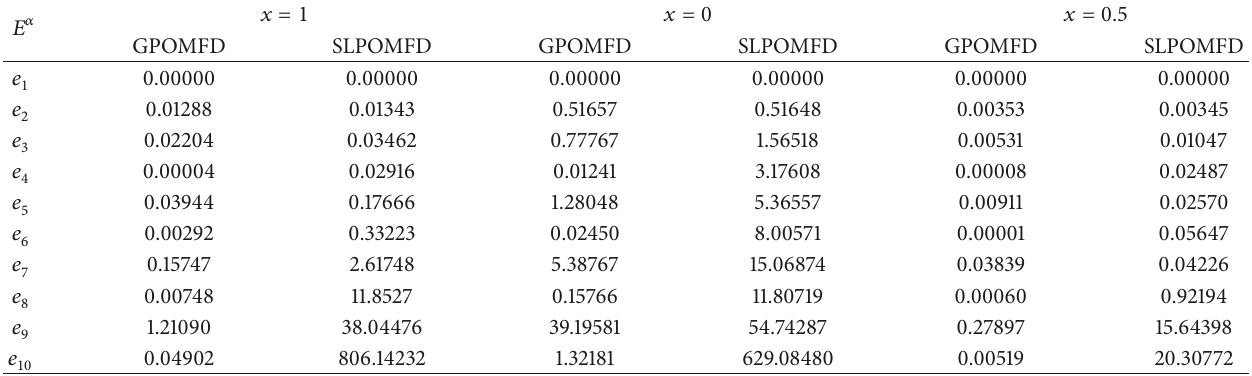
Table 1: Comparison of the operational matrix errors for the GPOMFD and